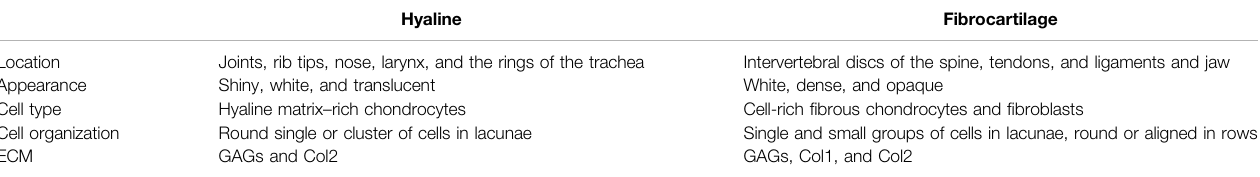
TABLE 1 | Summary of characteristics of hyaline and fi brocartilage. Hyaline Fibrocartilage Location Joints, rib tips, nose, larynx, and the rings of the trachea Intervertebral discs of the spine, tendons, and ligaments and jaw Appearance Shiny, white, and translucent White, dense, and opaque Cell type Hyaline matrix – rich chondrocytes Cell-rich fi brous chondrocytes and fi broblasts Cell organization Round single or cluster of cells in lacunae Single and small groups of cells in lacunae, round or aligned in rows